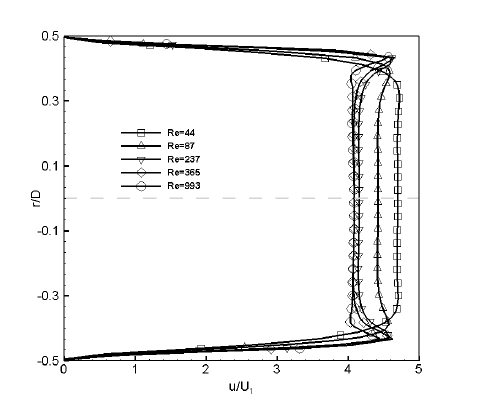
Figure 4. Velocity profiles at the contraction plane showing velocity